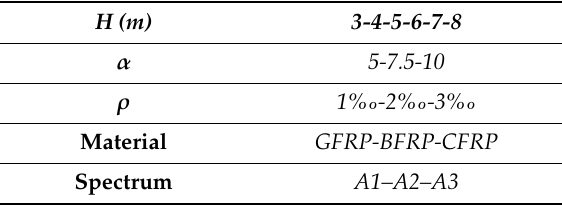
Table 1. Parameters considered in the parametric study.